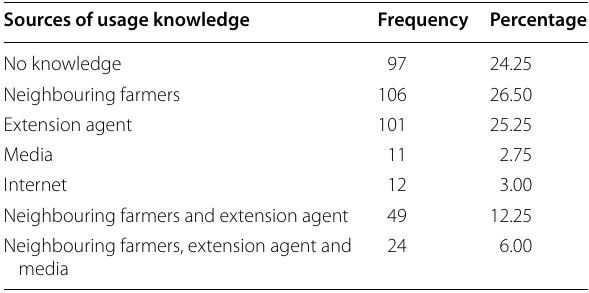
Table 6 Farmers’ source of knowledge of the use of vetiver grass. Source : Field Survey,